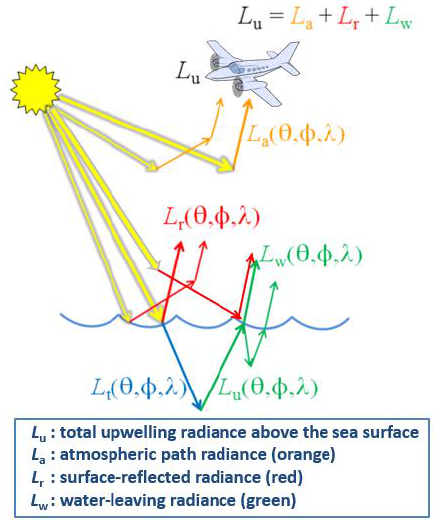
Figure 6 . Conceptual diagram of the contributions to the total upwelling radiance above the sea surface ( L u ) (Mobley et al ., 2020).